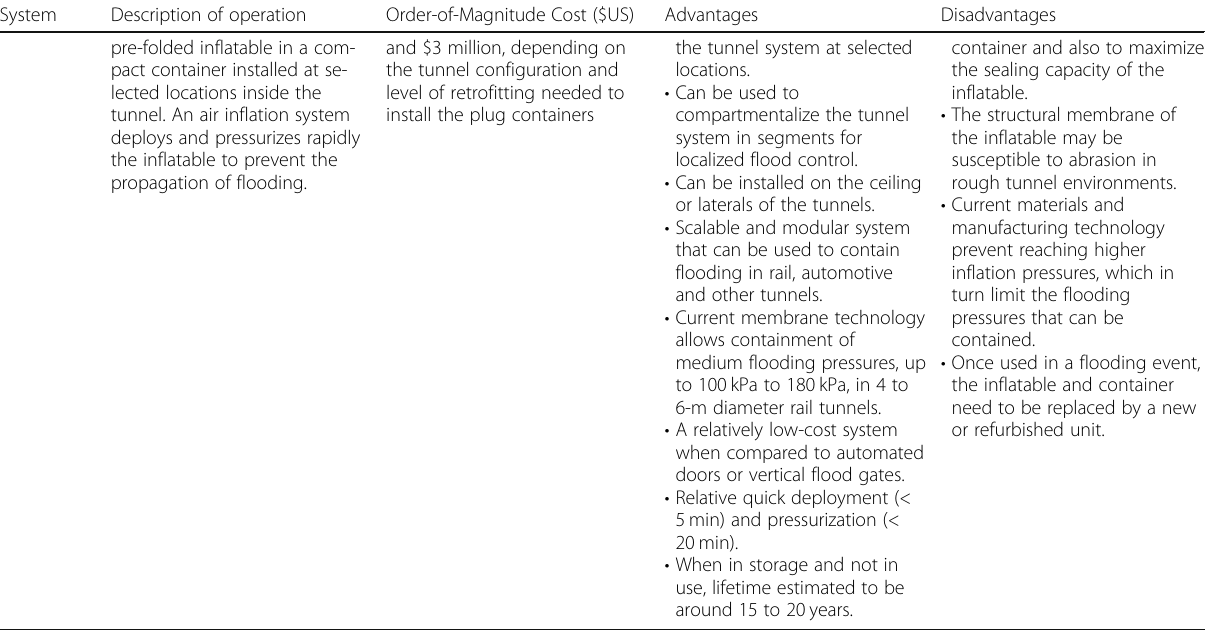
Table 1 Current technology used for flooding containment in transportation tunnels [2, 41]